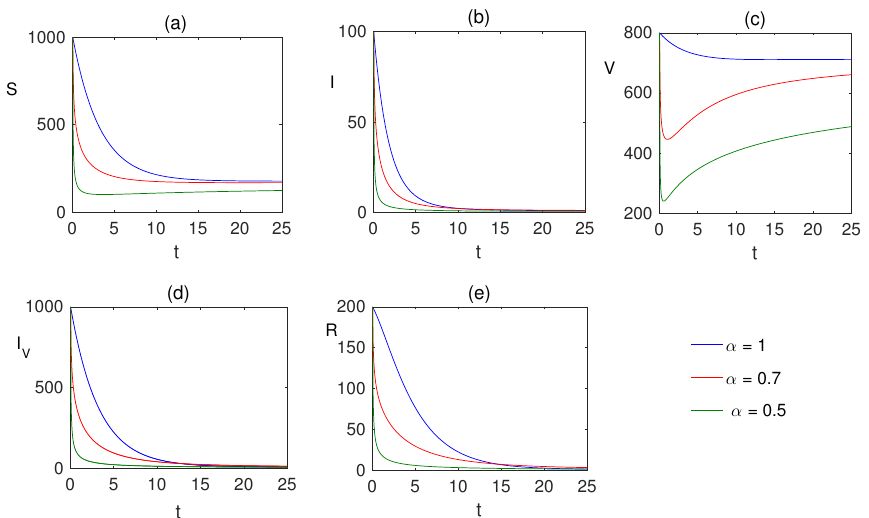
Figure 6. The numerical solution of ( a ) susceptible S ( t ) , ( b ) infected I ( t ) , ( c ) vaccinated population V ( t ) , ( d ) infected population after vaccination I V ( t ) and ( e ) recovered populations R ( t ) are plotted for showing the dynamics of the fractional ordered model (7) when α = 1, 0.7, 0.5 and where the fear factors are α 1 = 1.29 and α 2 =